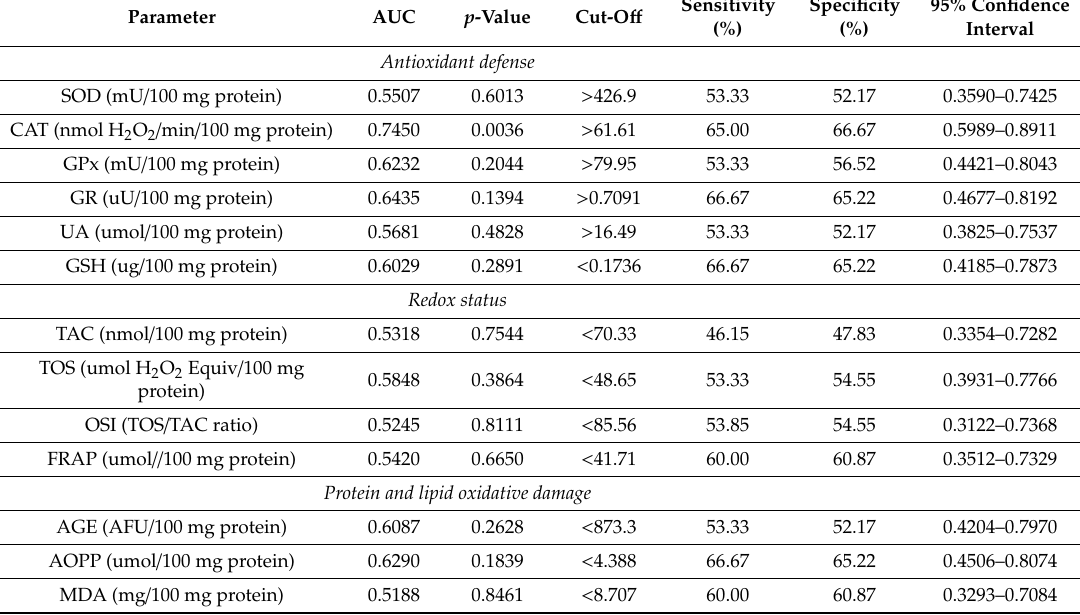
Table 3. Receiver operating characteristic (ROC) analysis of oxidative stress biomarkers of colorectal cancer patients with (N1 + N2) and without lymph node metastasis (N0). Abbreviations: SOD, superoxide dismutase-1; CAT, catalase; GPx, glutathione peroxidase; GR, glutathione reductase; UA, uric acid; GSH, reduced glutathione; TAC, total antioxidant capacity; TOS, total oxidant status; OSI, oxidative stress index; FRAP, ferric reducing ability of sample; AGE, advanced glycation end products; AOPP, advanced oxidation protein products; MDA,